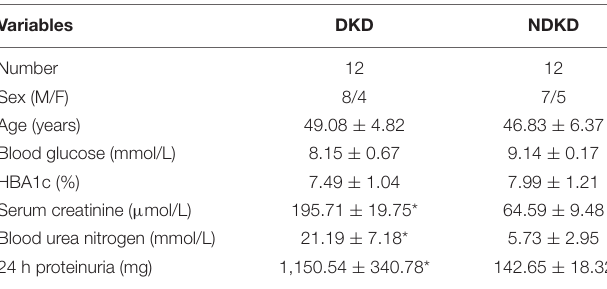
TABLE 2 | Baseline characteristics of DKD and NDKD (control)